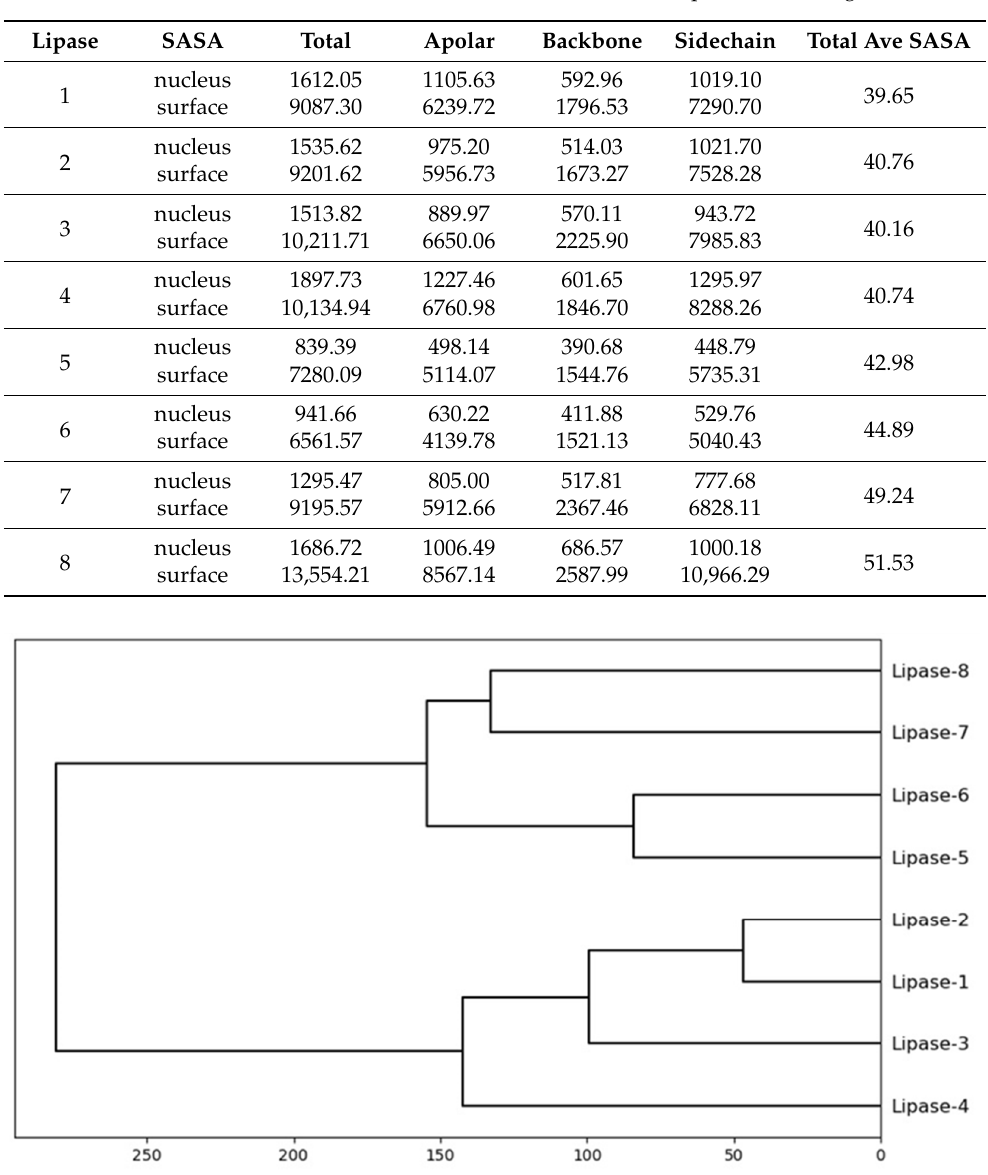
Figure 4. Hierarchical clustering of structurally conserved regions-SASA.